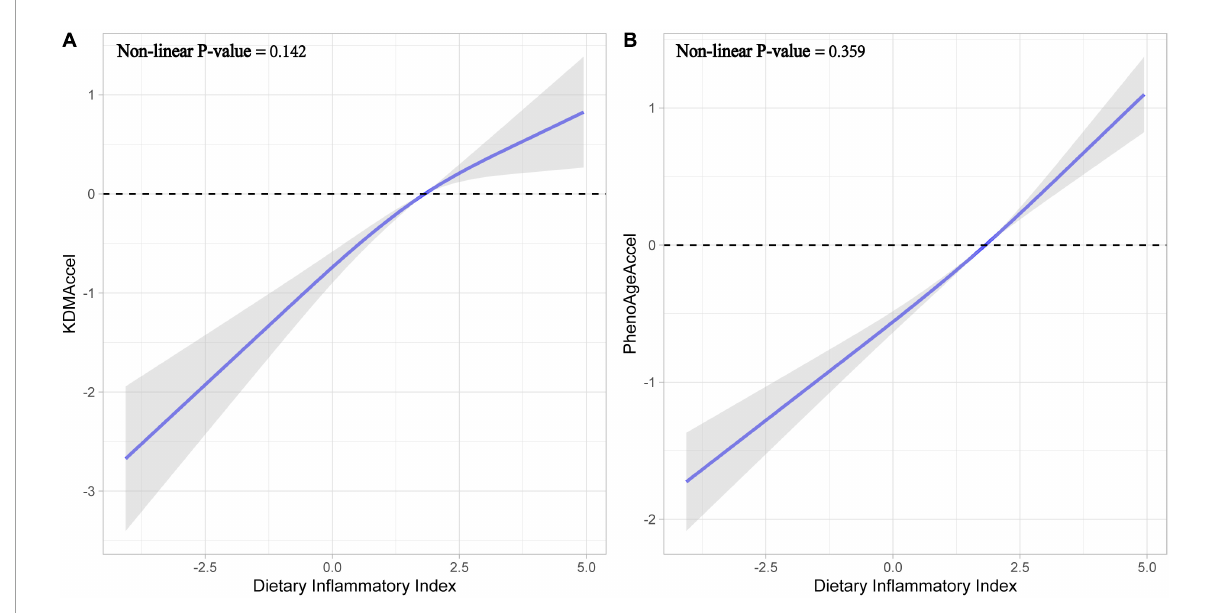
FIGURE3 Fitting curves for restricted cubic splines models. (A) Effect of dietary inflammatory index on KDMAccel. (B) Effect of dietary inflammatory index on